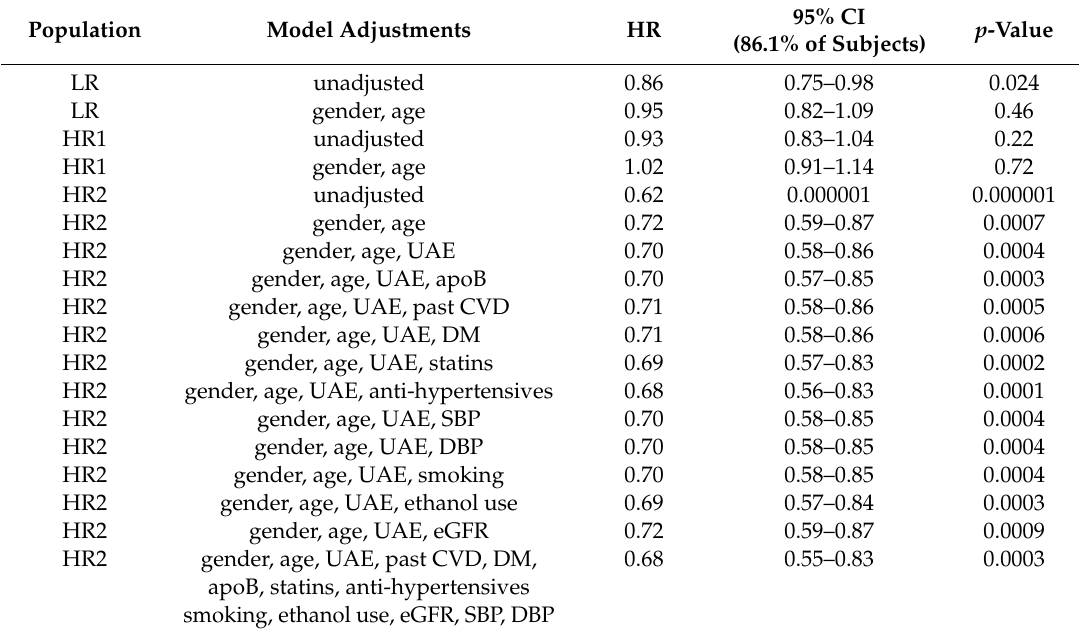
Table 3. Cox multivariable proportional hazards modeling results for PON1 level giving hazard ratio (HR), 95% confidence interval (95% CI), and p -value. The first column lists the population examined (LR, HR1, or HR2) along with parameters adjusted in models. Hazard ratios are per SD unit. For regression calculations, PON1 levels were transformed to a distribution with mean of zero and SD of